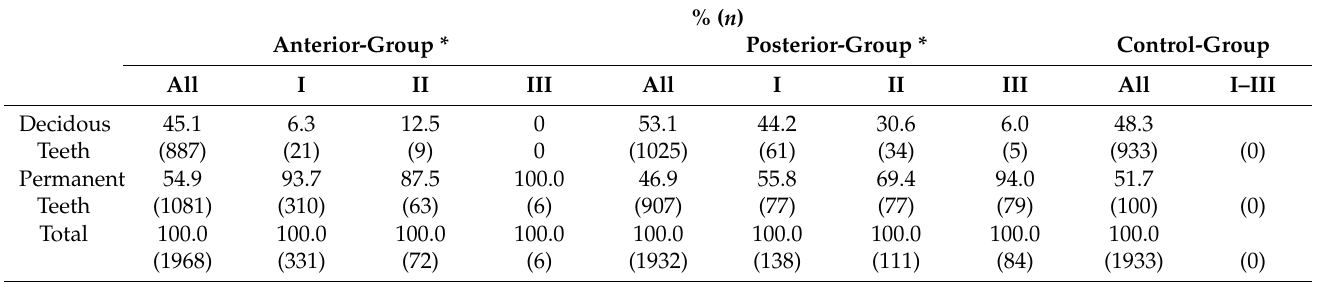
Table A3. Summary of data of 5833 teeth including MIH ( n = 742) with regard to dentition according to the EAPD-Criteria [3] and the MIH Classification by Mathu-Muju and Wright